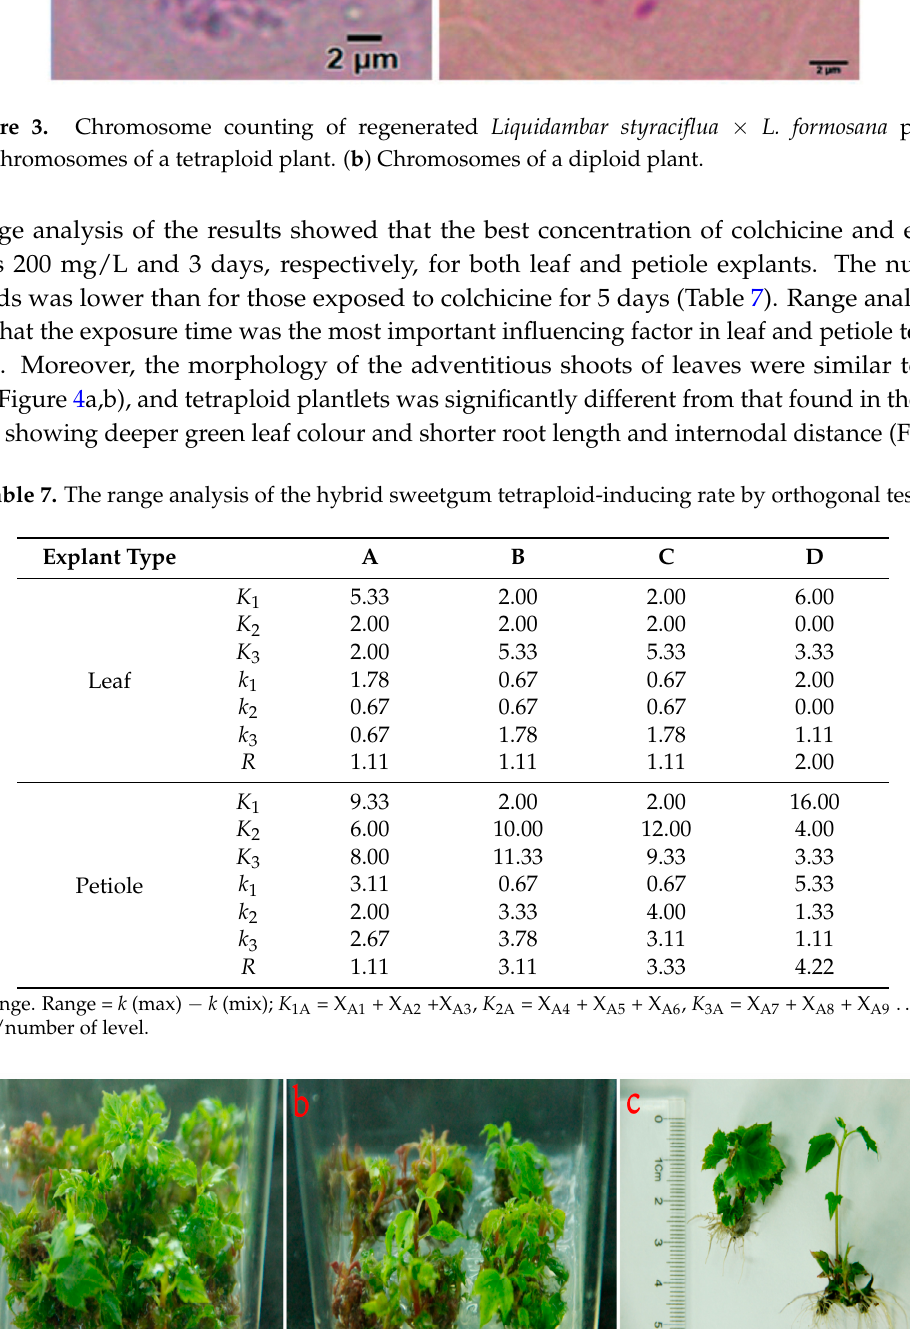
Figure 4. Morphology of shoot regeneration in Z3 leaves and petioles after 60 days. ( a ) leaf; ( b ) petiole; ( c ) tetraploid; (left) and diploid (right). Table 7. The range analysis of the hybrid sweetgum tetraploid-inducing rate by orthogonal test. Explant Type